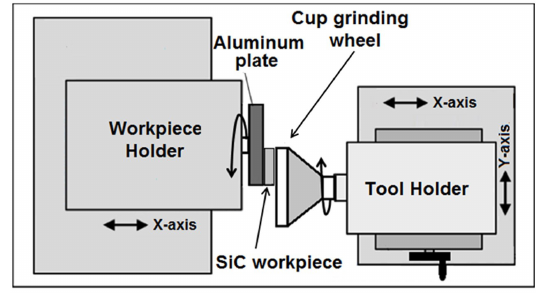
Figure 1. Scheme of the HKM 63 machine operation.